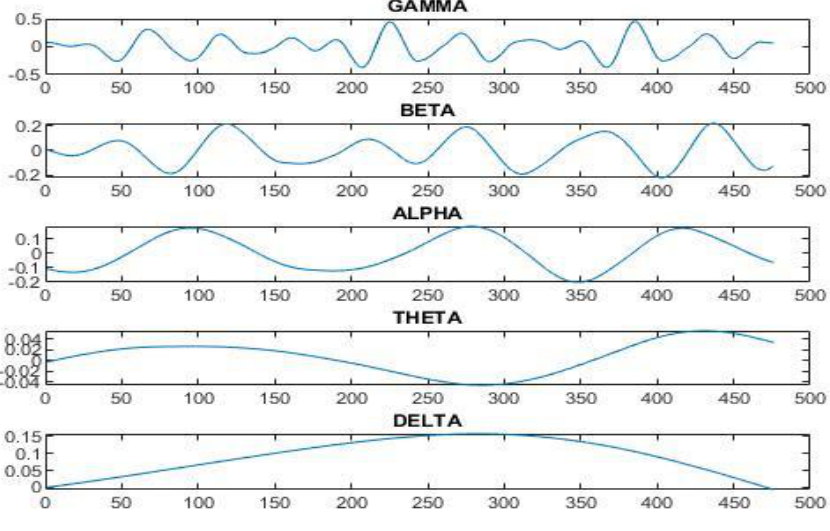
Figure 5. EEG brain waves.